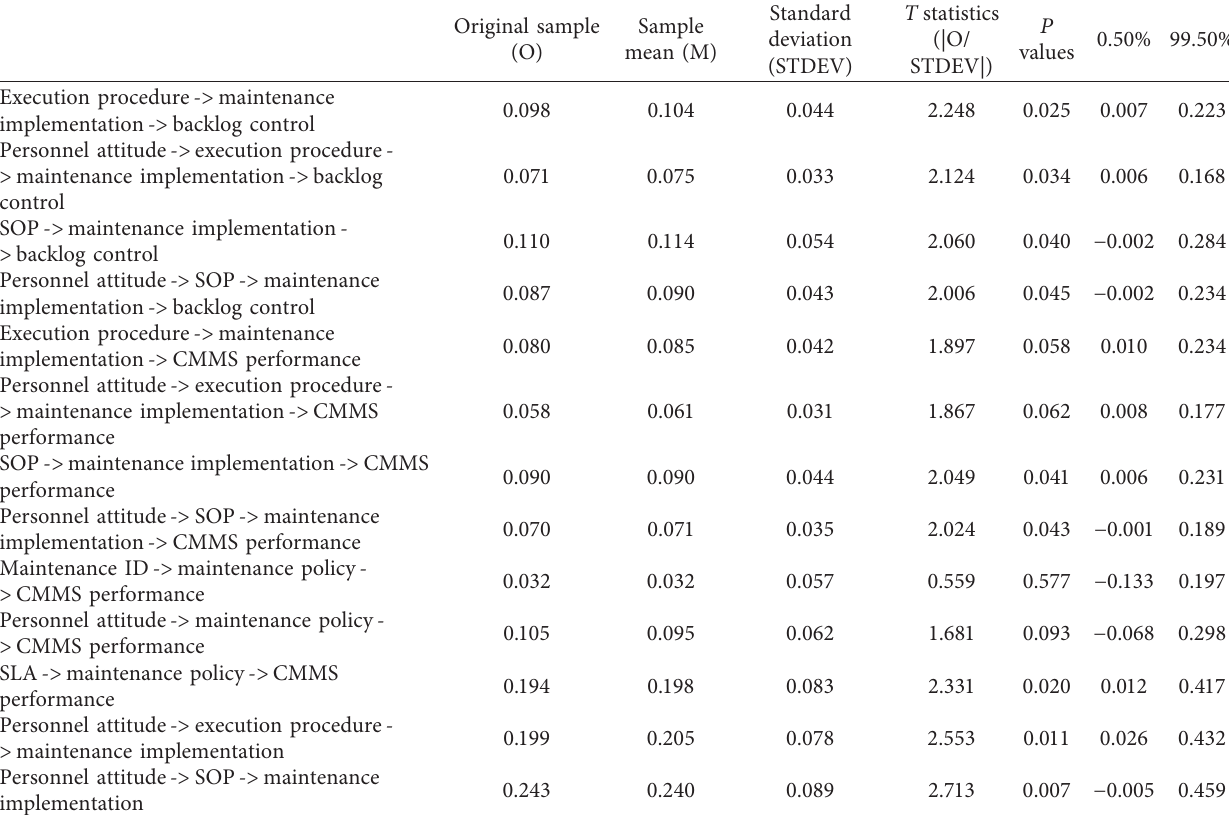
Table 4: Specific indirect effects for hypothesis